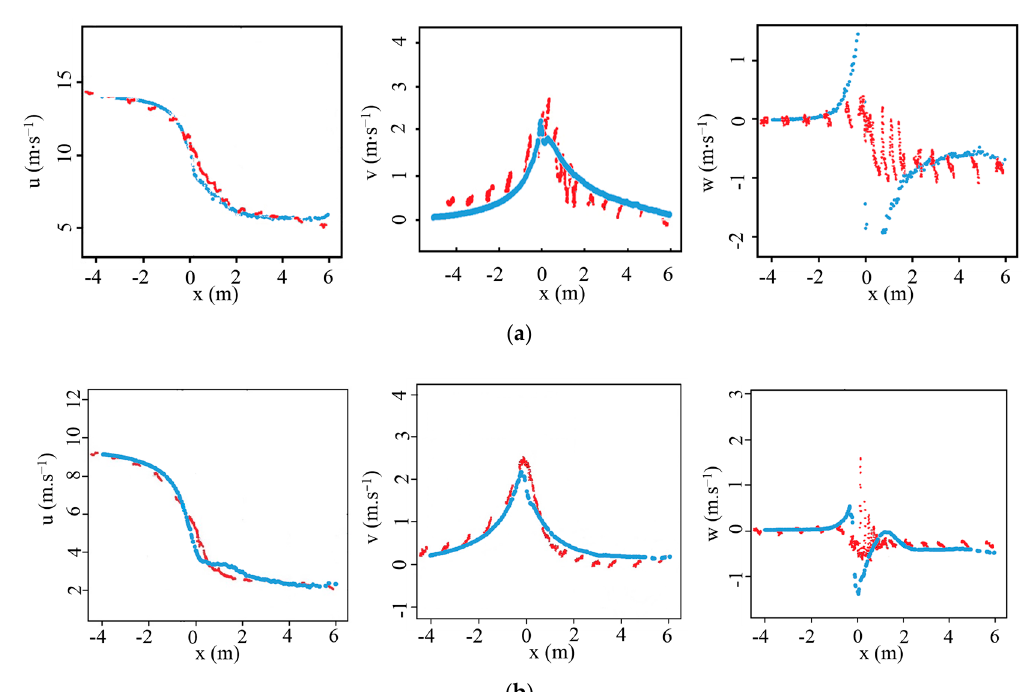
Figure 8. Validation dataset for an axial traverse at R = 1.8 m, showing comparison between computational and experimental data for ( a ) Free ‐ Stream Velocity U = 15 m ∙ s − 1 ; ( b ) Free ‐ Stream Velocity U = 10 m ∙ s − 1 . The blue lines represent the computational data and the red lines represent experimental data.